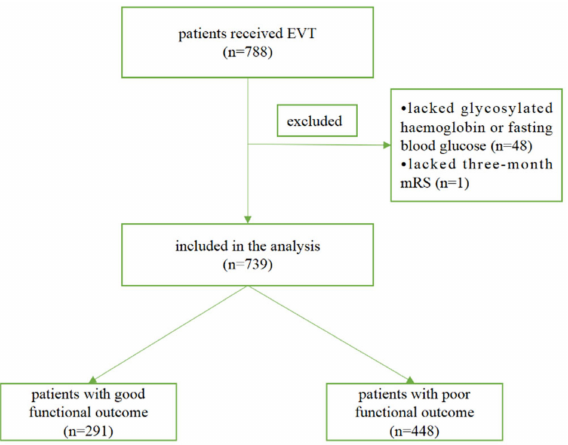
Figure 1. Study flow diagram. Good functional outcome was defined as mRS ≤ 2 and poor functional outcome was defined as mRS > 2 at three months. Table 1. Baseline characteristics of